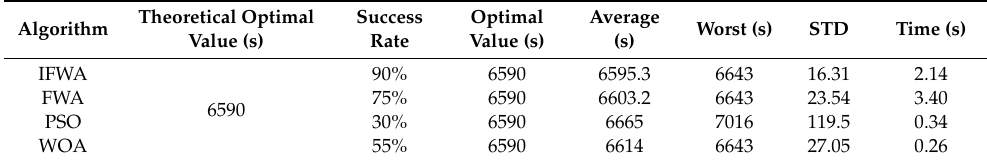
Table 3. Results of the optimizations in PFSP.